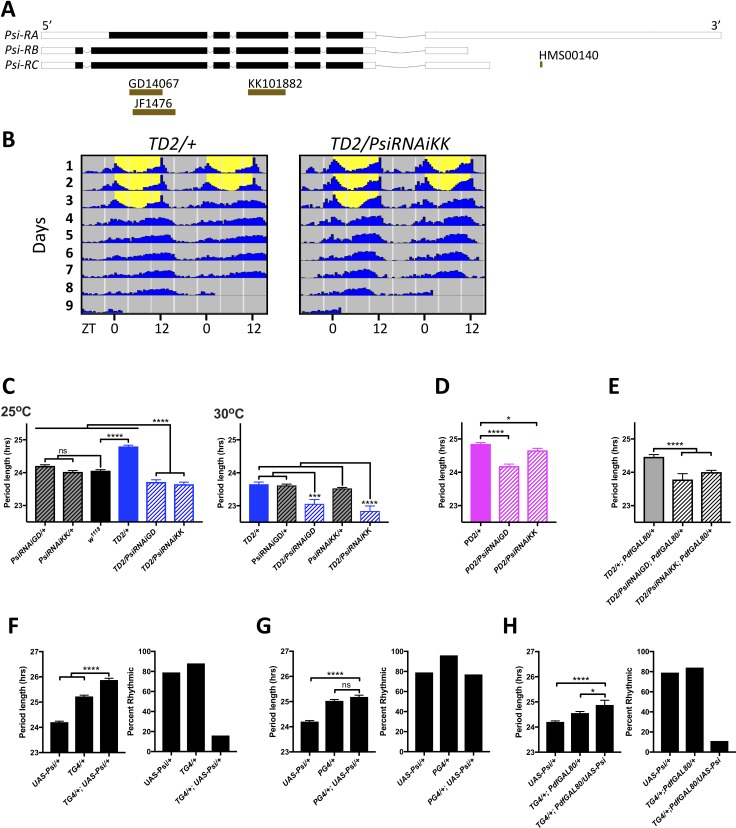
Expression level of Psi affects the circadian behavior period length and circadian rhythmicity.(A) Schematic of Psi isoforms and position of the long and short hairpins used in this study. Adapted from Ensembl 94 (Zerbino et al., 2018). (B–E) Knockdown of Psi shortens the behavioral period. (B) Double-plotted actograms showing the average activities during 3 days in LD and 5 days in DD. Left panel: TD2/+ (control) flies. Right panel: TD2/PsiRNAi (Psi knockdown) flies. Note the short period of Psi knockdown flies. n = 8 flies/genotype. (C–E) Circadian period length (hrs) is plotted on the y axis. Genotypes are listed on the x axis. Error bars represent SEM. Solid black bar is w1118 (WT) control; solid blue, magenta and gray bars are driver controls; patterned bars are Psi knockdown with two non-overlapping RNAi lines: GD14067 (PsiRNAiGD) and KK101882 (PsiRNAiKK). *p<0.05, ***p<0.001, ****p<0.0001, one-way ANOVA followed by Tukey’s multiple comparison test (C) Dunnett’s multiple comparison test (D and E). (C) Knockdown in all circadian tissues. Left panel 25°C, right panel 30°C. Note that even at 25°C, the experimental flies are shorter than their respective RNAi/+ control, despite the dominant period lengthening caused by TD2 (D) Knockdown in PDF+ circadian pacemaker neurons. (E) Knockdown in PDF- circadian tissues. In D and E, only the driver controls are shown, since they are the controls which the experimental flies need to be compared to because of the dominant period lengthening caused by PD2 and TD2. (F–H) Overexpression of Psi lengthens the behavioral period and decreases rhythmicity. Left panels: Circadian period length (hrs) is plotted on the y axis. Error bars represent SEM. Right panels: Percent of flies that remained rhythmic in DD is plotted on the y axis. Both panels: Genotypes are listed on the x axis. Not significant (ns)p>0.05, *p<0.05, ****p<0.0001, one-way ANOVA followed by Tukey’s multiple comparison test. (F) Overexpression of Psi in all circadian tissues lengthened the circadian period and decreased the percent of rhythmic flies. (G) Overexpression of Psi in PDF+ circadian pacemaker neurons caused a slight but non-significant period lengthening compared to the driver control (PG4/+), which is the relevant comparison because of the dominant period lengthening caused by PG4. Rhythmicity was slightly reduced compared to PG4/+ but not compared to UAS-Psi/+. (H) Overexpression of Psi in PDF- circadian tissues lengthened the circadian period and decreased rhythmicity.Figure 2—source data 1.Psi downregulation and overexpression – behavior data.Figure 2—source data 2.Figure statistics – Figure 2.